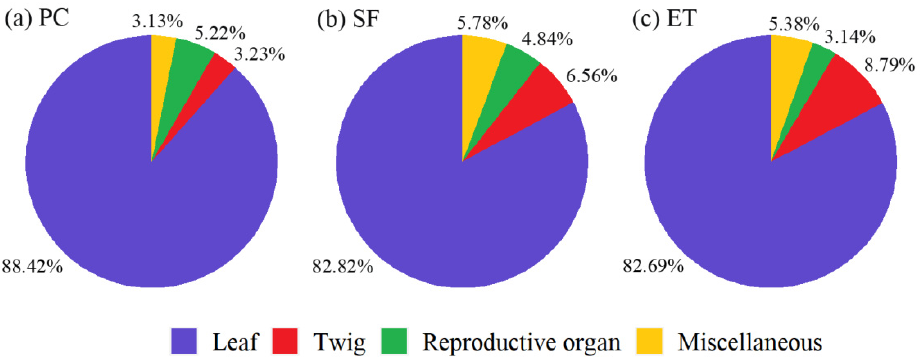
Figure 2. The proportions of each litter component in the total litterfall in different plantations. ( a ) PC: pure cypress; ( b ) SF: strip filling; ( c ) ET: ecological thinning.